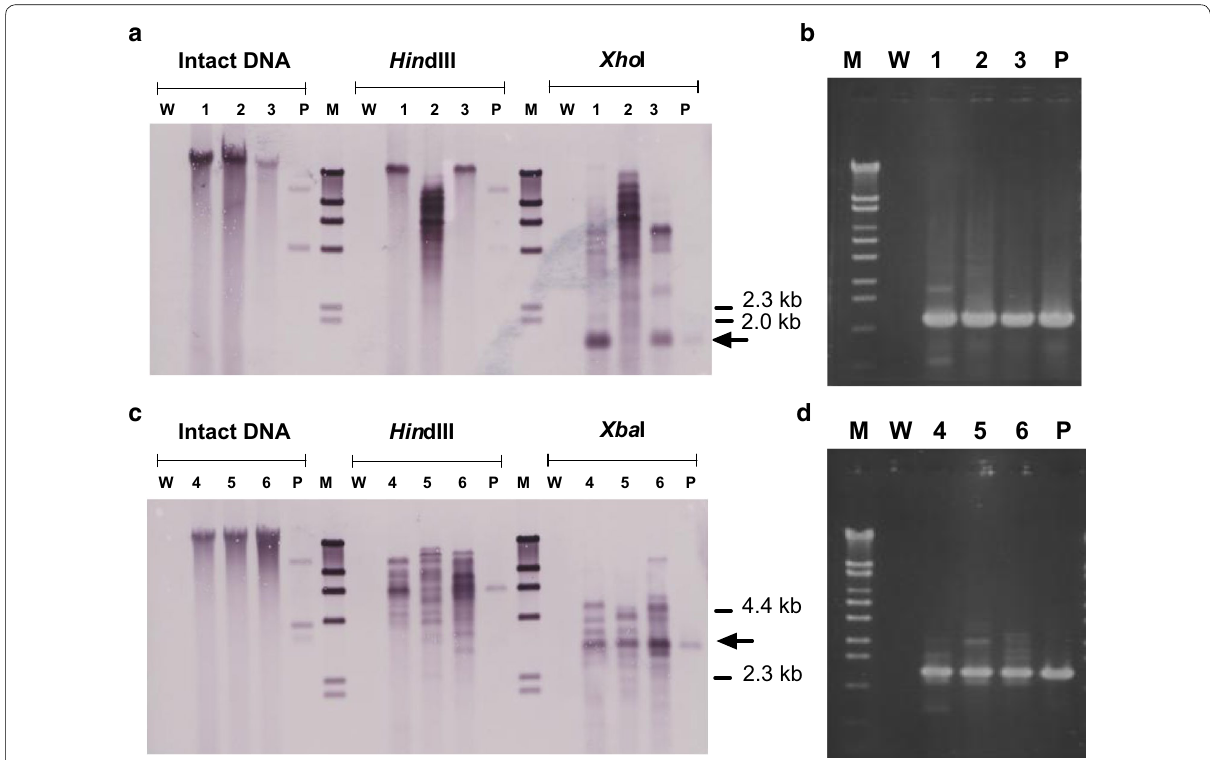
Fig. 3 Detection of the hph cassette in stable transformants treated with pCsGi- hph ( a and b ) and pCsbtubi- hph ( c and d ). a , c Southern hybridization analysis. Intact DNA, Hin dIII- and Xho I-digested total genomic DNA from independent transformants (lanes 1–3, pCsGi- hph ; 4–6, pCsbtubi- hph ), host wild-type strain (lane W), and the respective plasmid (lane P) were probed with DIG-labeled hph sequence. b , d Specific amplification of hph in genomic PCR. Lane M, DNA marker; Lane W, wild-type host strain as a negative control; Lanes 1–3 and 4–6, pCsGi- hph and pCsbtubi- hph transformants, respectively; Lane P: plasmid pCsGi- hph ( b ) and pCsbtubi- hph ( d ) as a positive